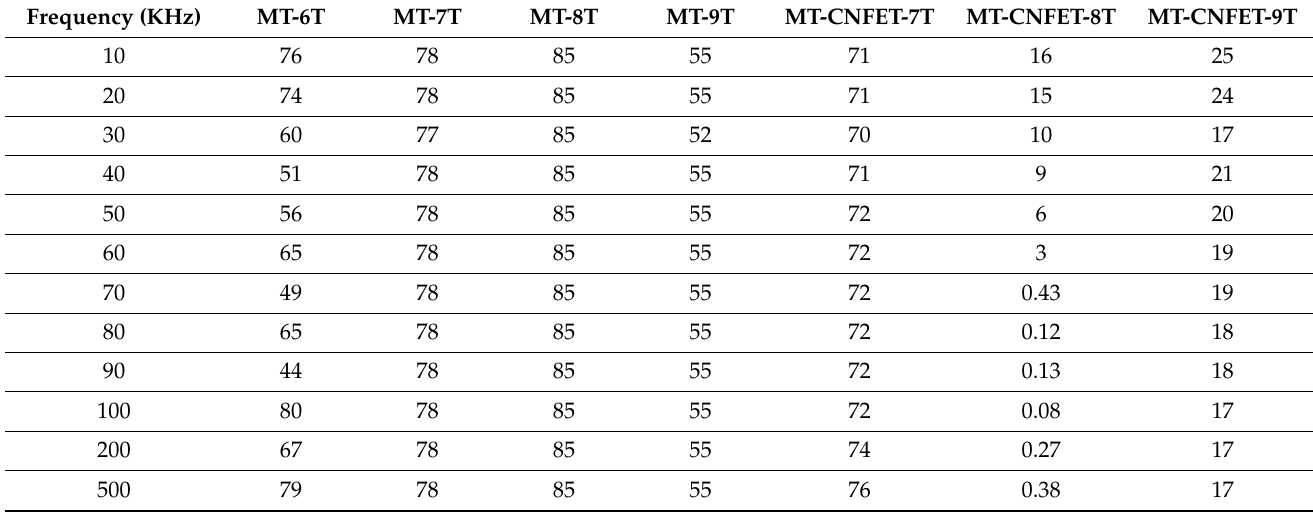
Table 4. Vout Improvement (%)–Proposed MT- CNFET 6T SRAM Cell vs. Other MT- SRAM